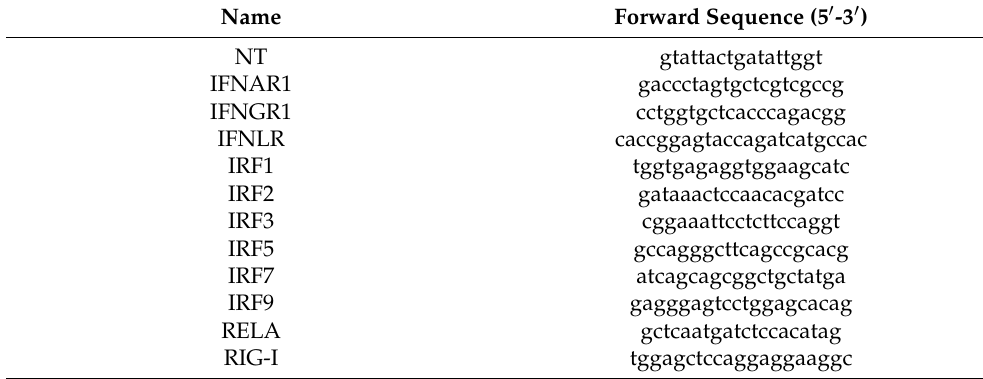
Table 1. Target-specific guide RNAs used for cloning into lentiCRISPR v2